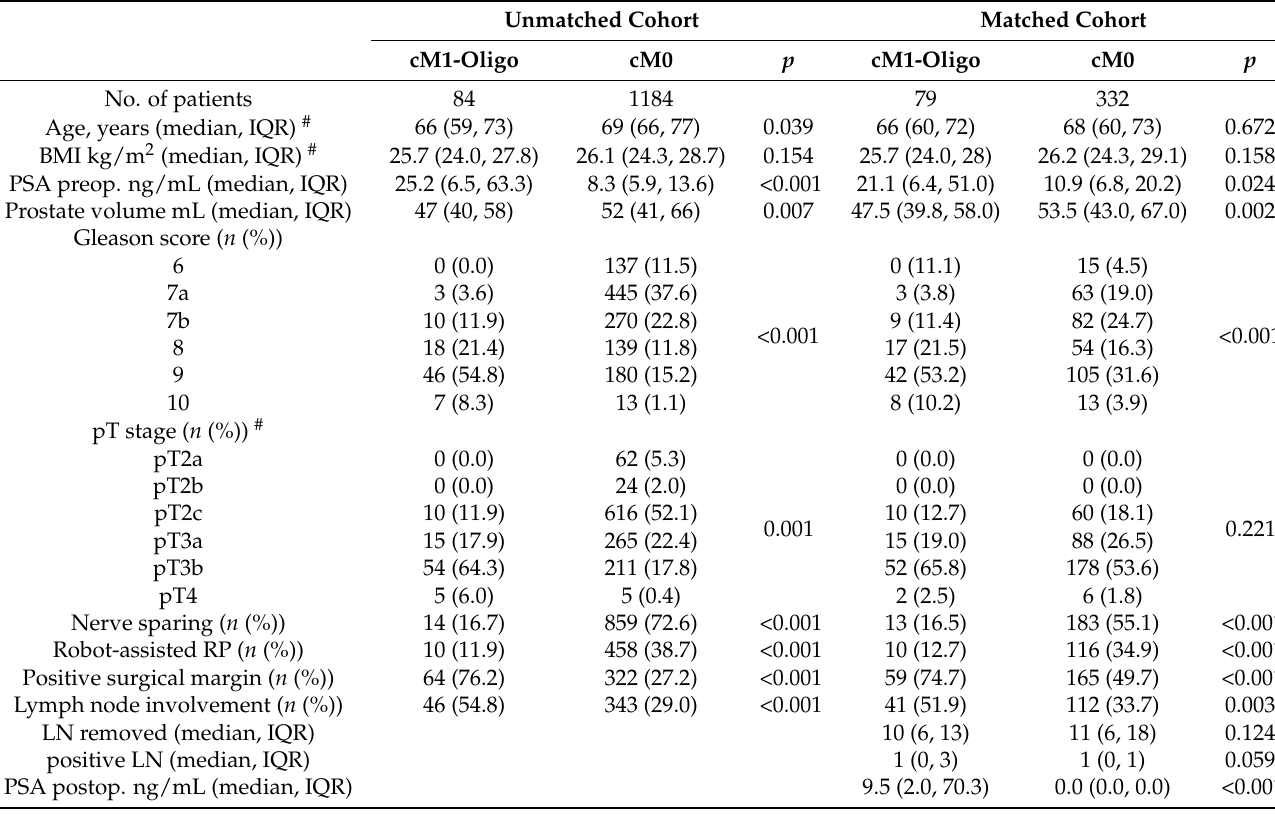
Table 1. Perioperative patient characteristics, Bold values indicate p -values < 0.05 and were considered statistically significant. Continuous values are presented as median and inter-quartile-range (IQR); categorical values are given as number ( n ; %) BMI : Body-Mass-Index; PSA preop: preoperative Prostate-specific Antigen level; LN: